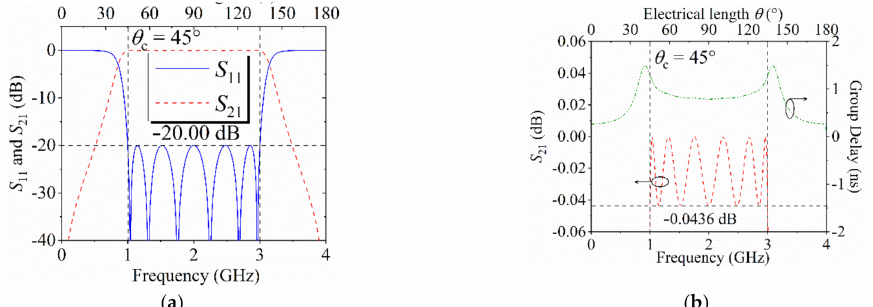
Figure 10. Circuit simulations of the 7 selected examples in Table 5. ( a ) Circuit simulations of S 11 and S 21 . ( b ) Enlarged circuit simulations of S 21 and group delay.